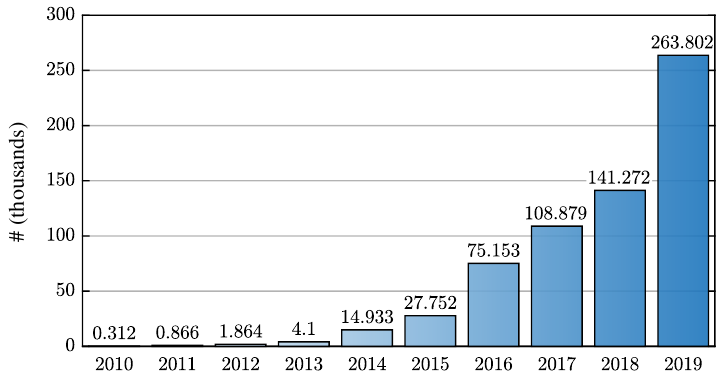
Figure 1. Cumulative electric vehicle fast chargers installed worldwide, including AC 43kW chargers, DC chargers, Tesla Superchargers and high-power inductive chargers